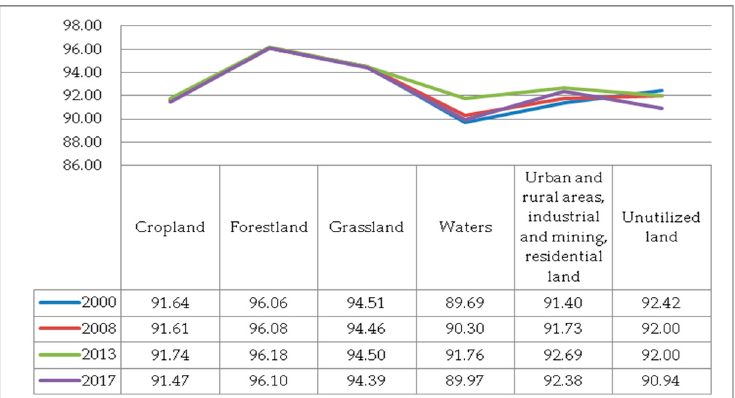
Figure 9. The Aggregation Index (AI) of various types of landscape.